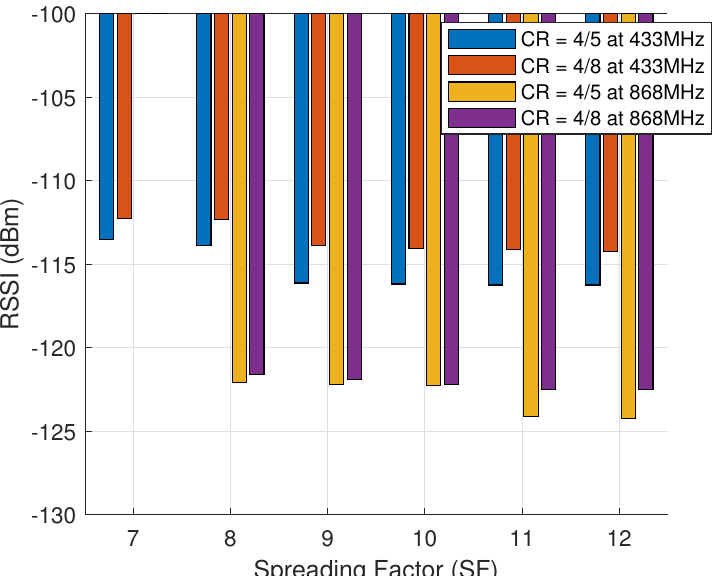
Figure 14. RSSI registered between the GW and POS 2 for different SF and CR